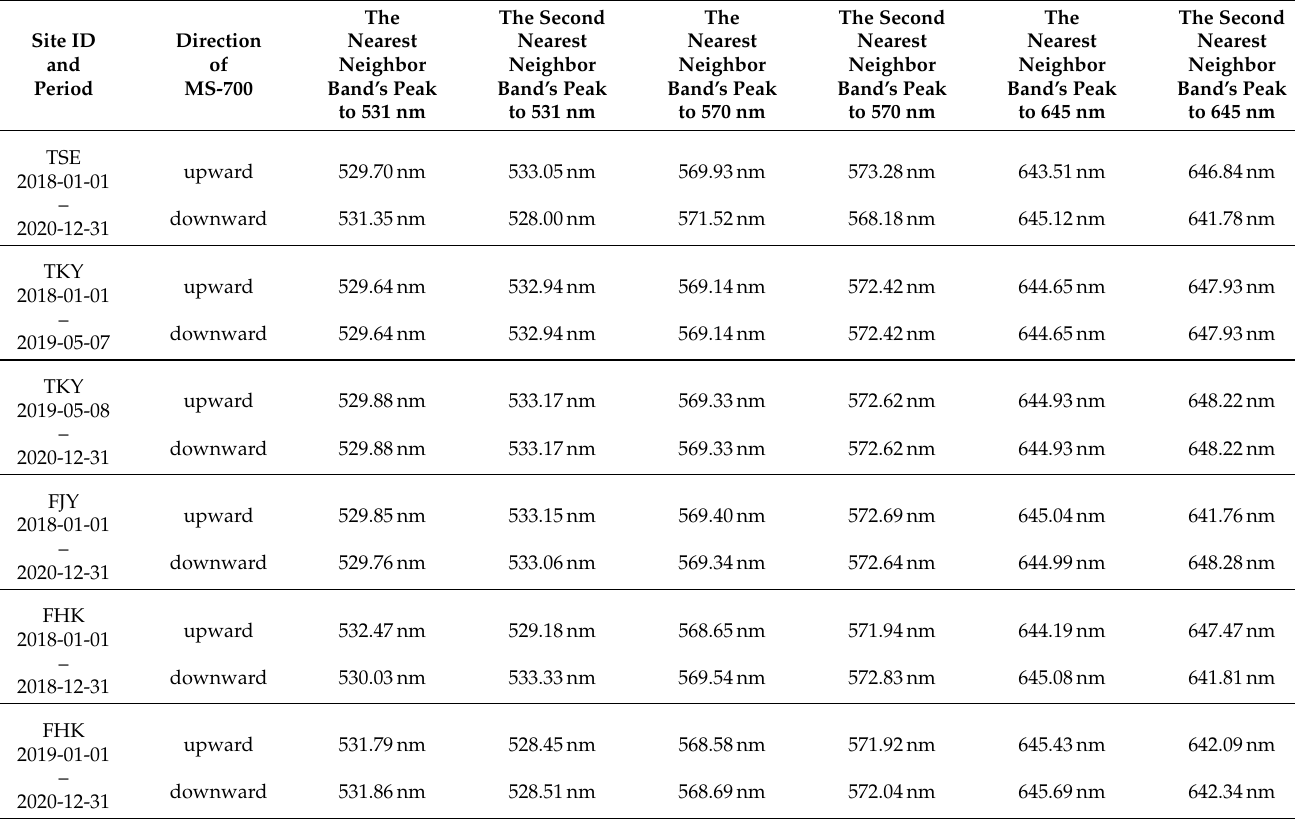
Table A1. The center wavelengths of the MS-700 bands which were the nearest or the second